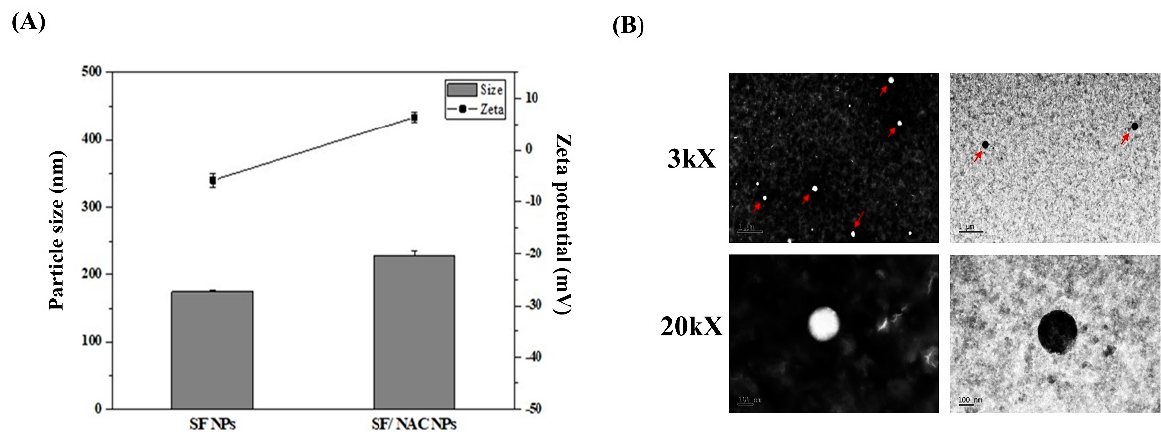
Figure 1. ( A ) Particle size and Zeta potential for SF and SF/NAC NPs. ( B ) The TEM morphology for SF and SF/NAC NPs. (bar: 1 μ m and 100 nm for images of 3 kX and 200 kX, respectively).